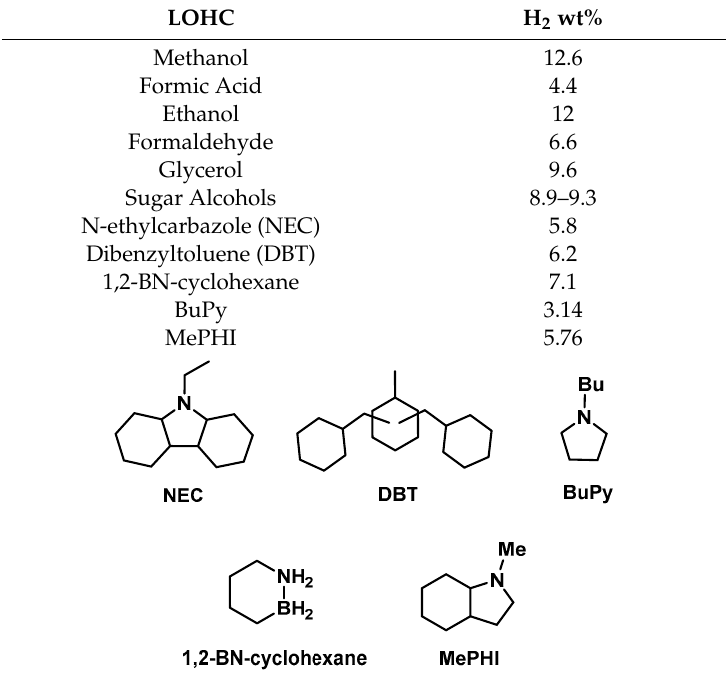
Table 1. Hydrogen weight percentage stored in some representative liquid organic hydrogen carriers (LOHCs). LOHC H 2 wt% Methanol Formic